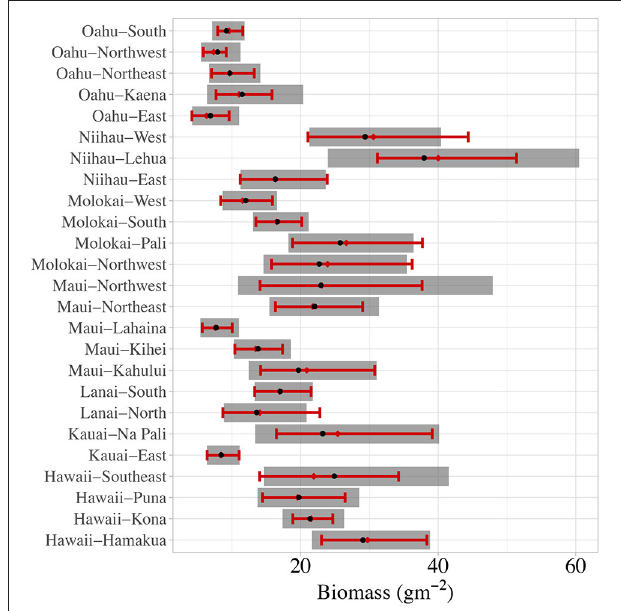
FIGURE 4 | Observed (red whiskers) vs. predicted (gray rectangles) 95% quantiles for sector-level total reef fish